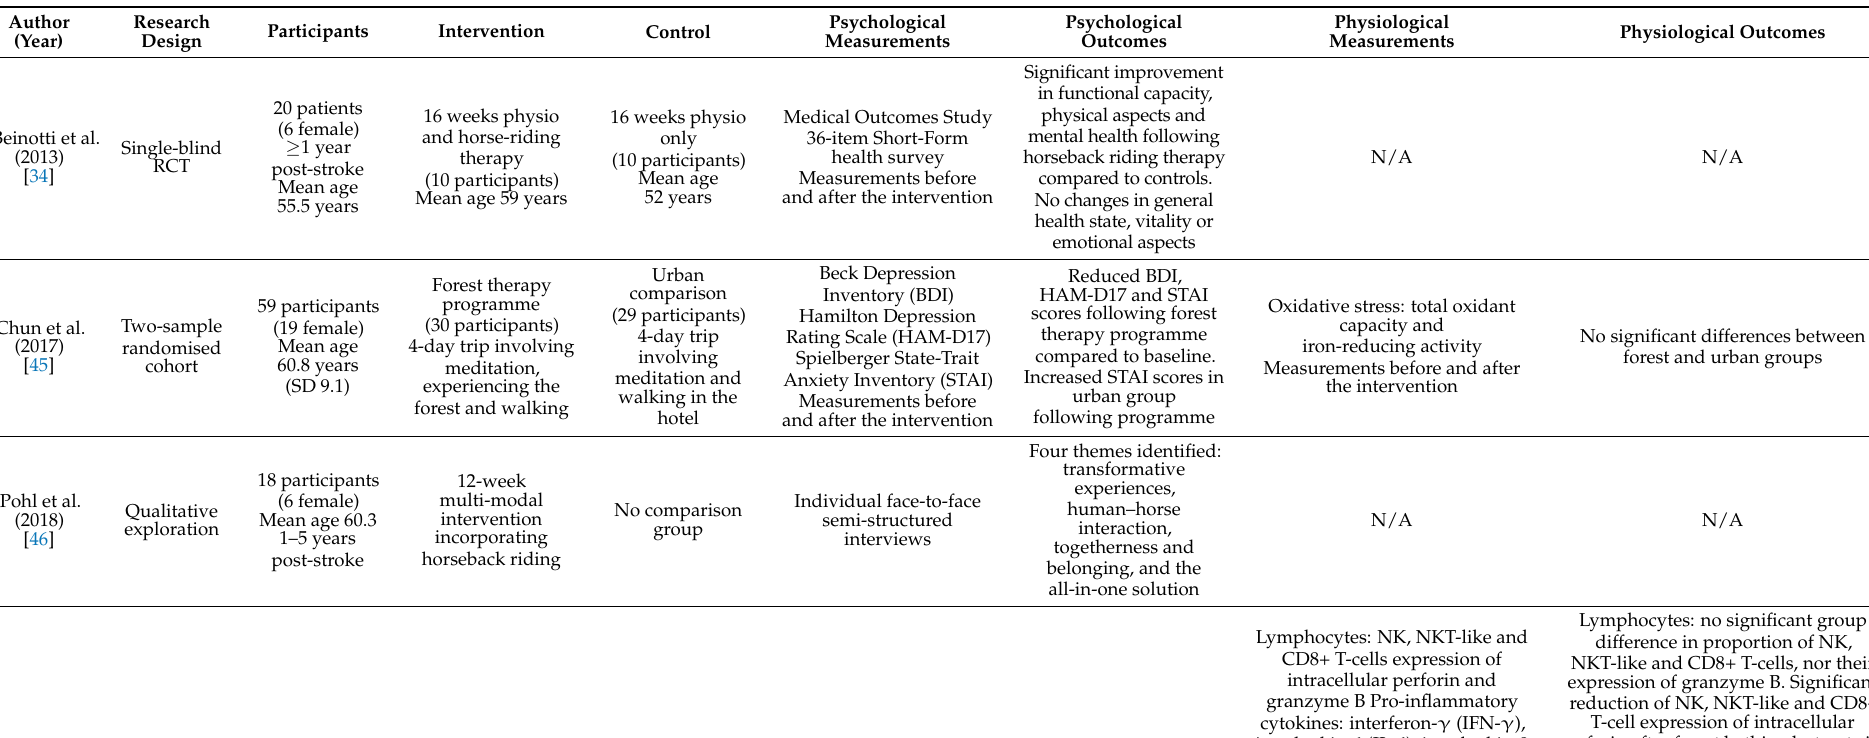
Table 3. Summary of study